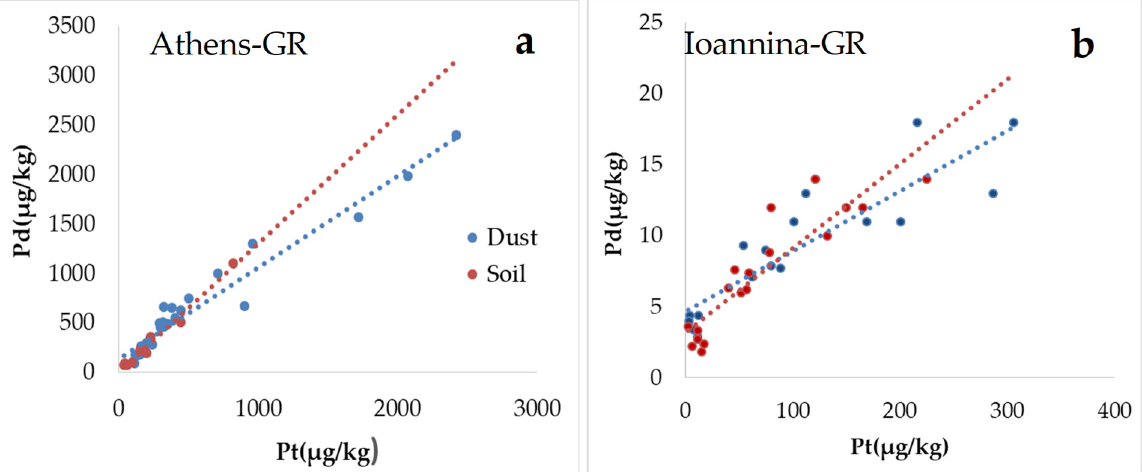
Figure 4. Plots of Pd versus Pt content in dust and soil samples along roadsides of the Athens Basin ( a ) and the Ioannina city ( b ). Data from Table 1 and [16].